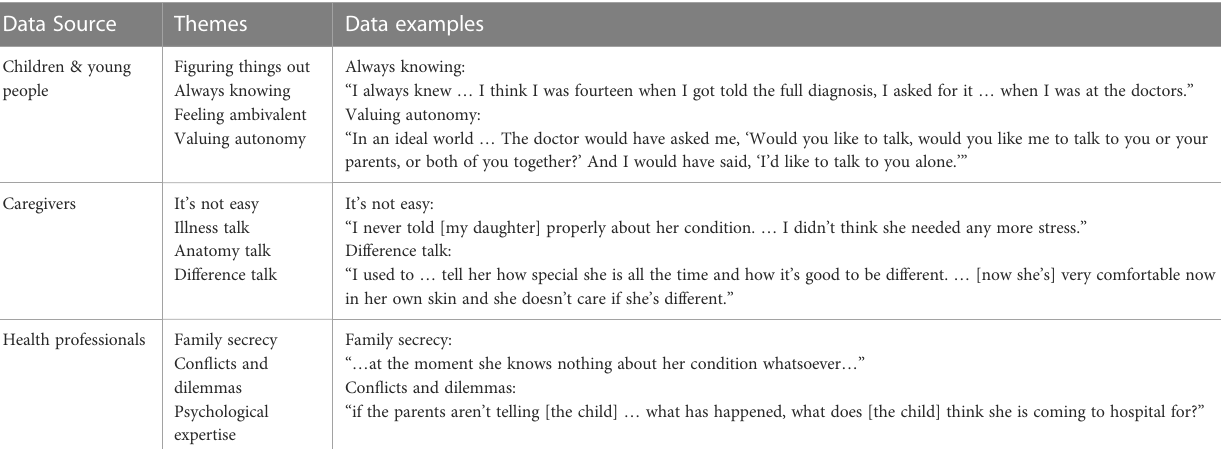
TABLE 1 Overview of data sources and